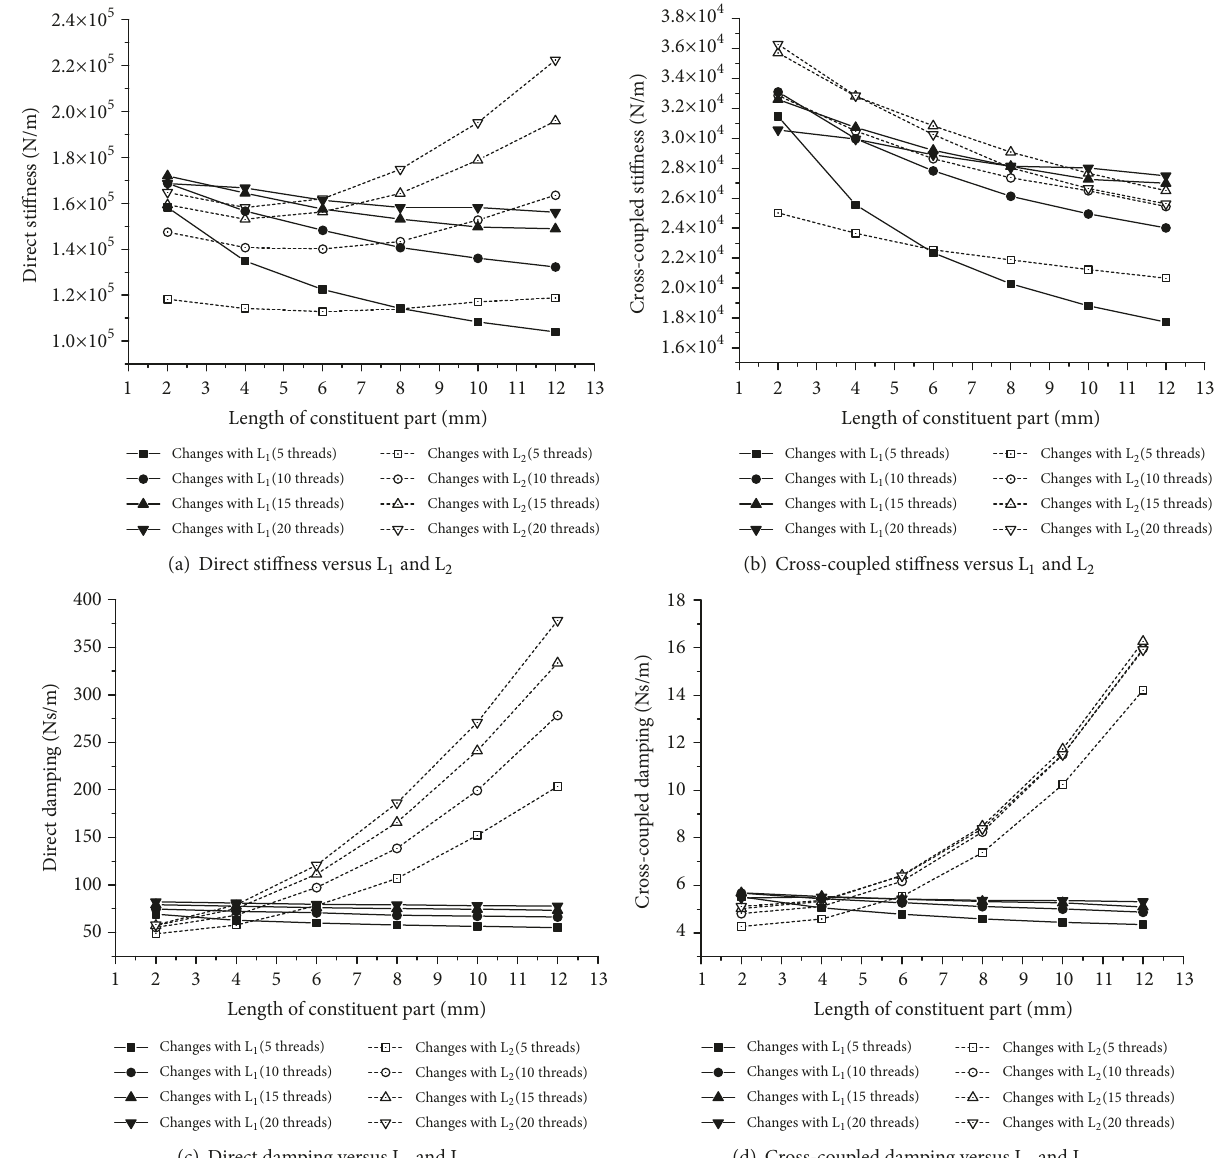
Figure 10: Dynamic characteristic changes versus L 1 and L 2